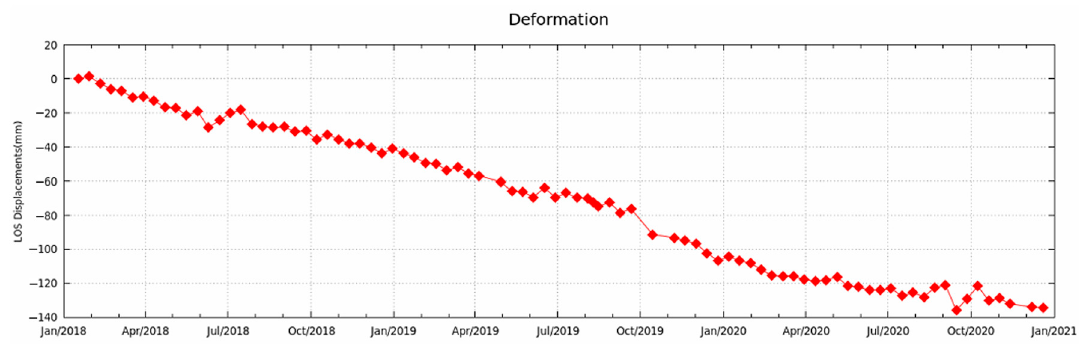
Figure 8. Identification of hidden danger points of Miaodao Archipelago. ( a ) The mean displacement velocity; ( b ) Enlarged view of areas with large mean displacement velocity.